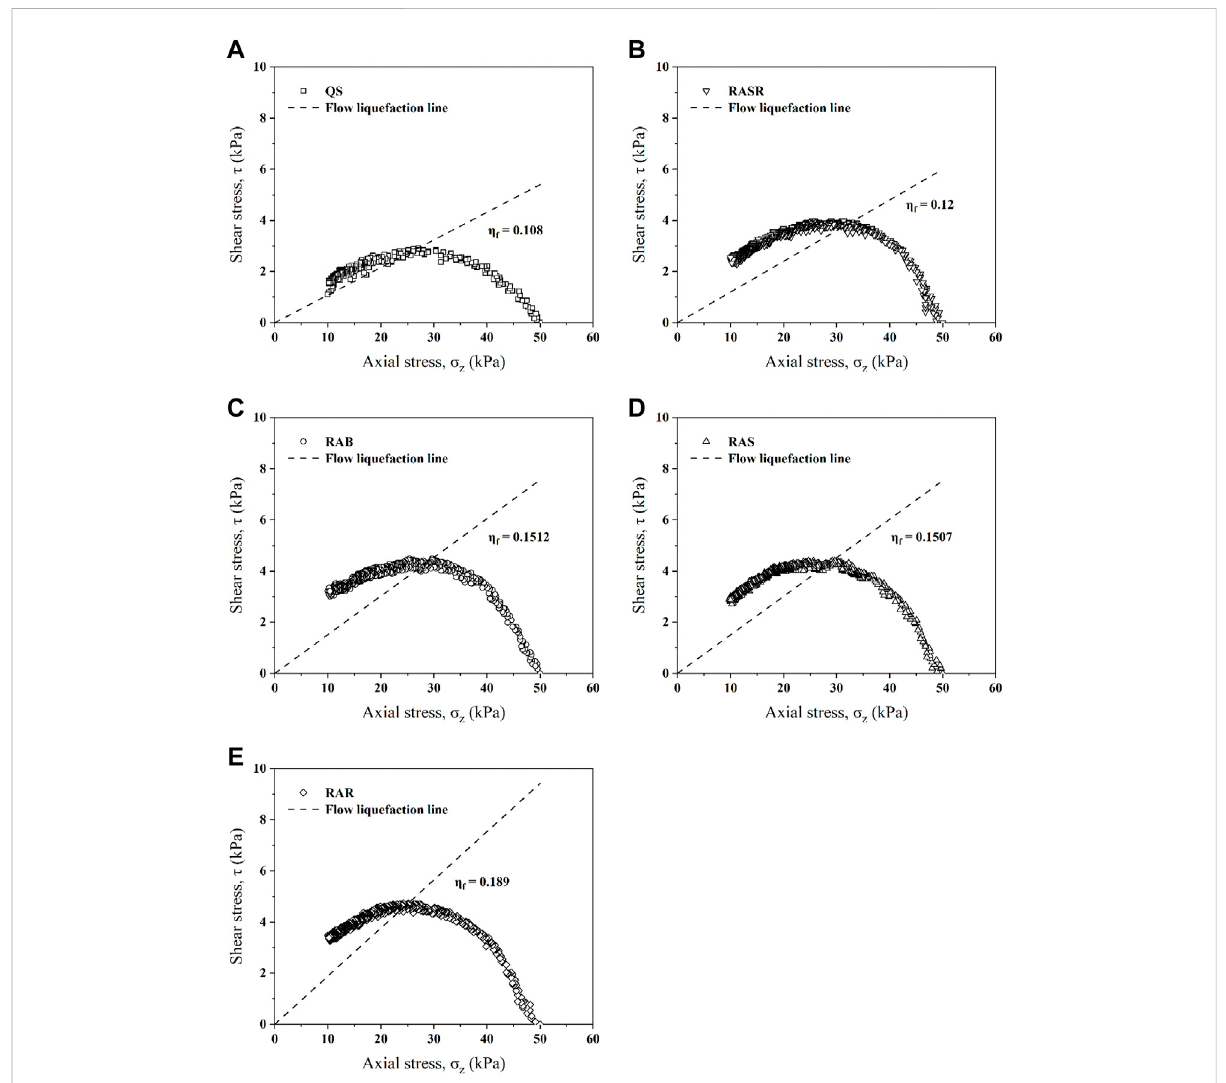
FIGURE 6 Flow liquefaction lines in the space of shear stress t versus axial stress σ z in the monotonic simple shear tests for: (A) QS; (B) RASR; (C) RAB; (D) RAS; (E) RAR.